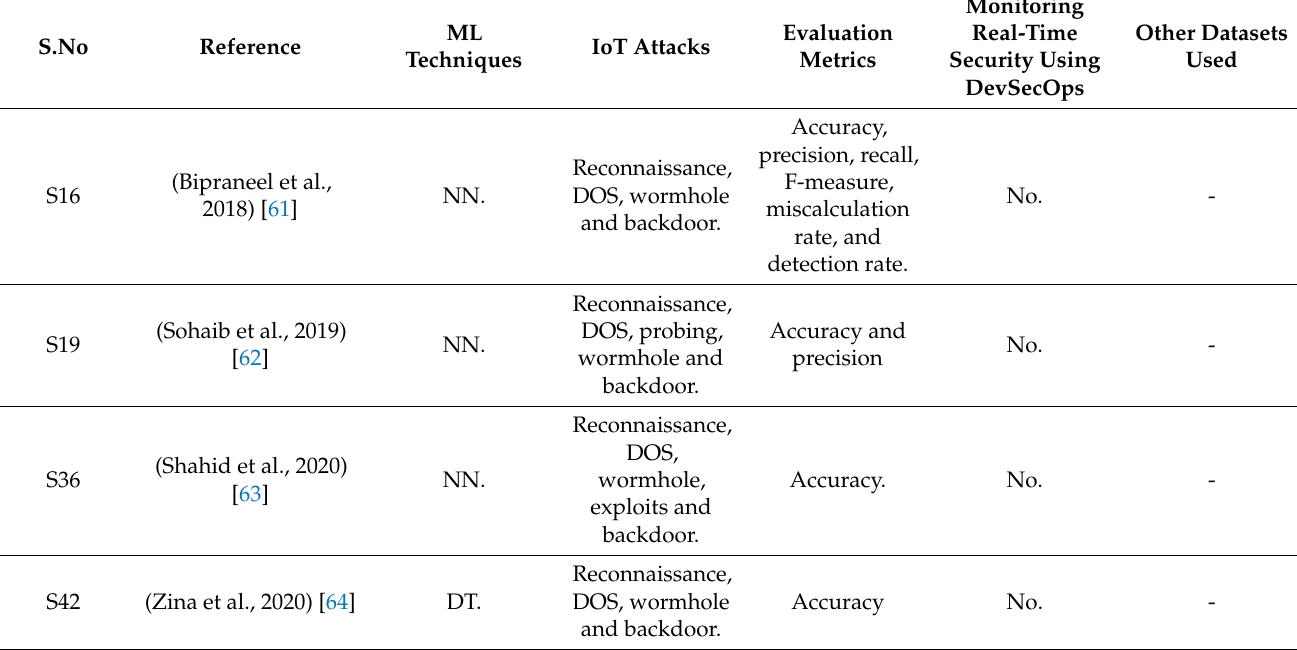
Table 7. UNSW-NB15